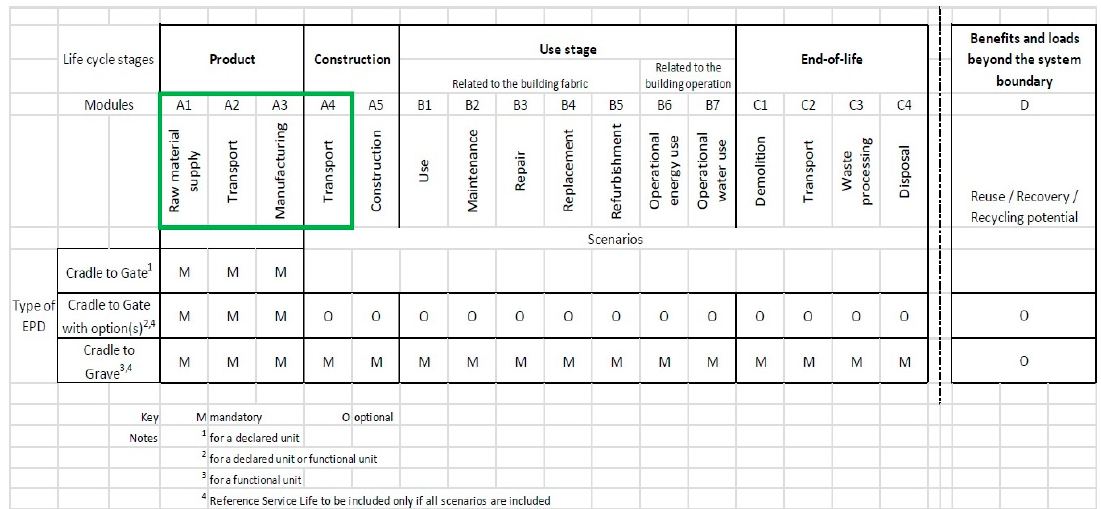
Figure 1. Life cycle stages according to the standard EN 15804 and boundary setting of this study.